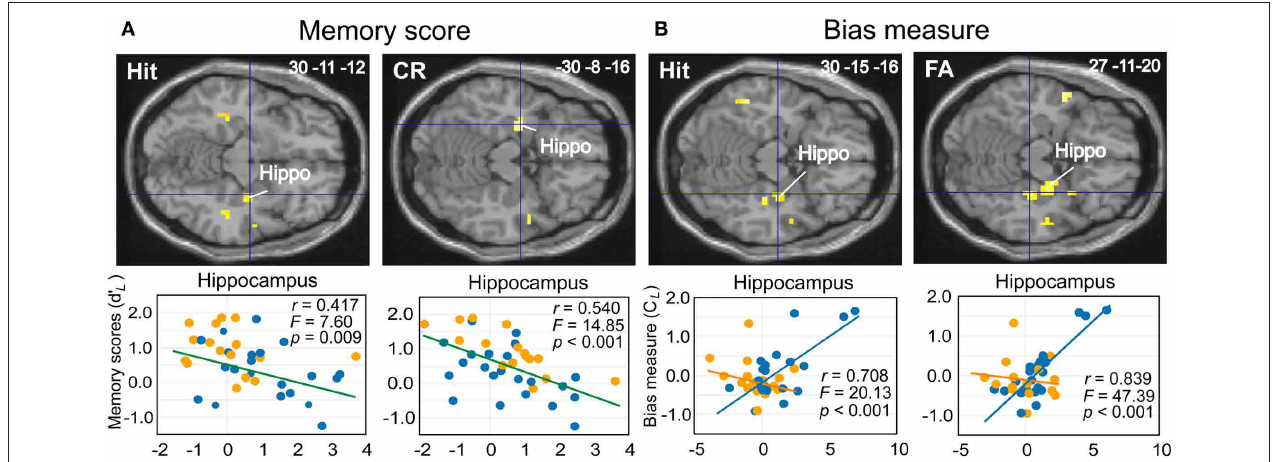
scan. Scatter diagrams represent variability in the levels of activation of young FIguRe 9 | Linear regression analyses. (A) Decreases of activation intensity (orange dots) and elderly (blue dots) subjects for a type of response category as (beta values) in the hippocampus as a function of memory scores ( d ) for Hit and L ′ a function of memory or response bias scores. Green, blue, and orange lines, CR in all subjects. (B) Increases of activation intensity in the hippocampus as a regression lines for all subjects, elderly and young, respectively. function of response bias scores ( C ) for Hit and FA in the elderly. The activations L are superimposed on axial sections of the normalized Tl-weighted structural